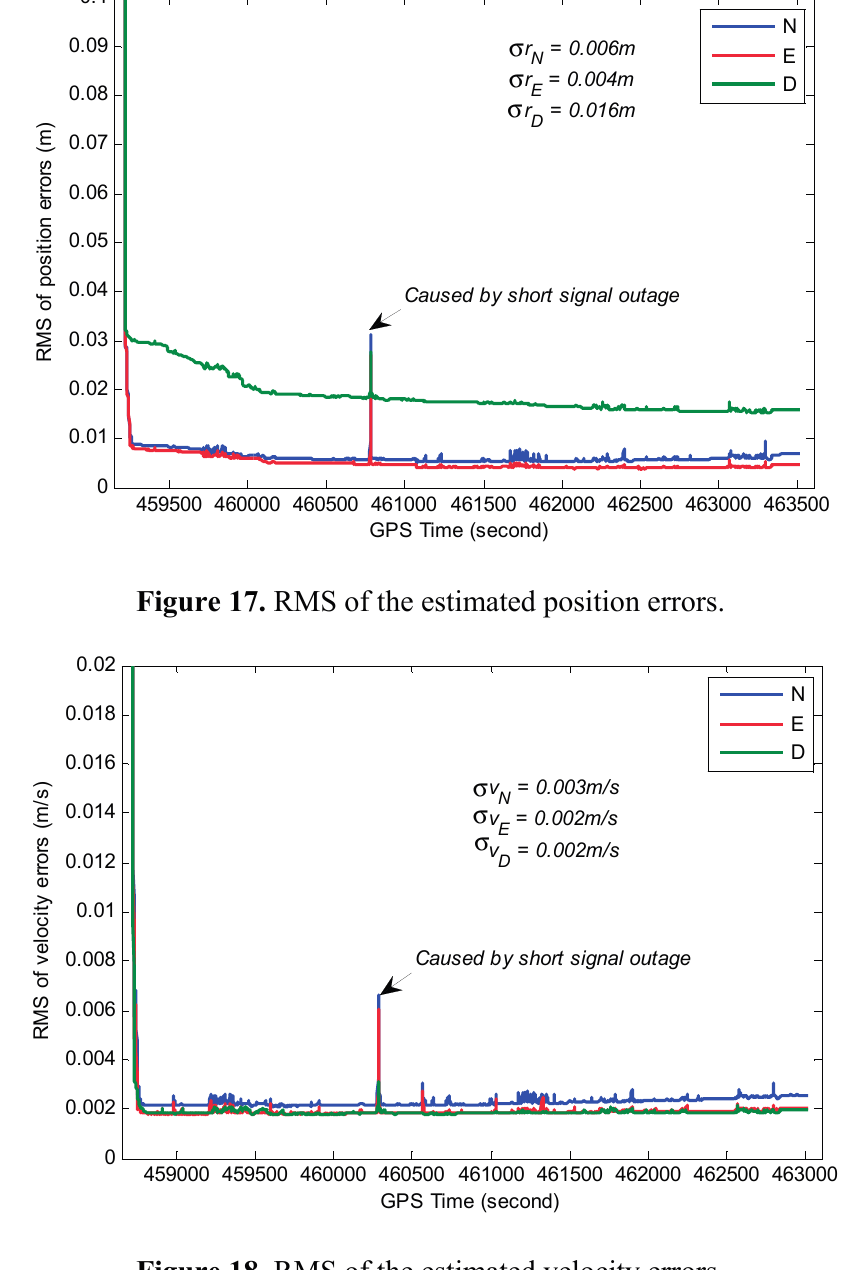
Figure 18. RMS of the estimated velocity